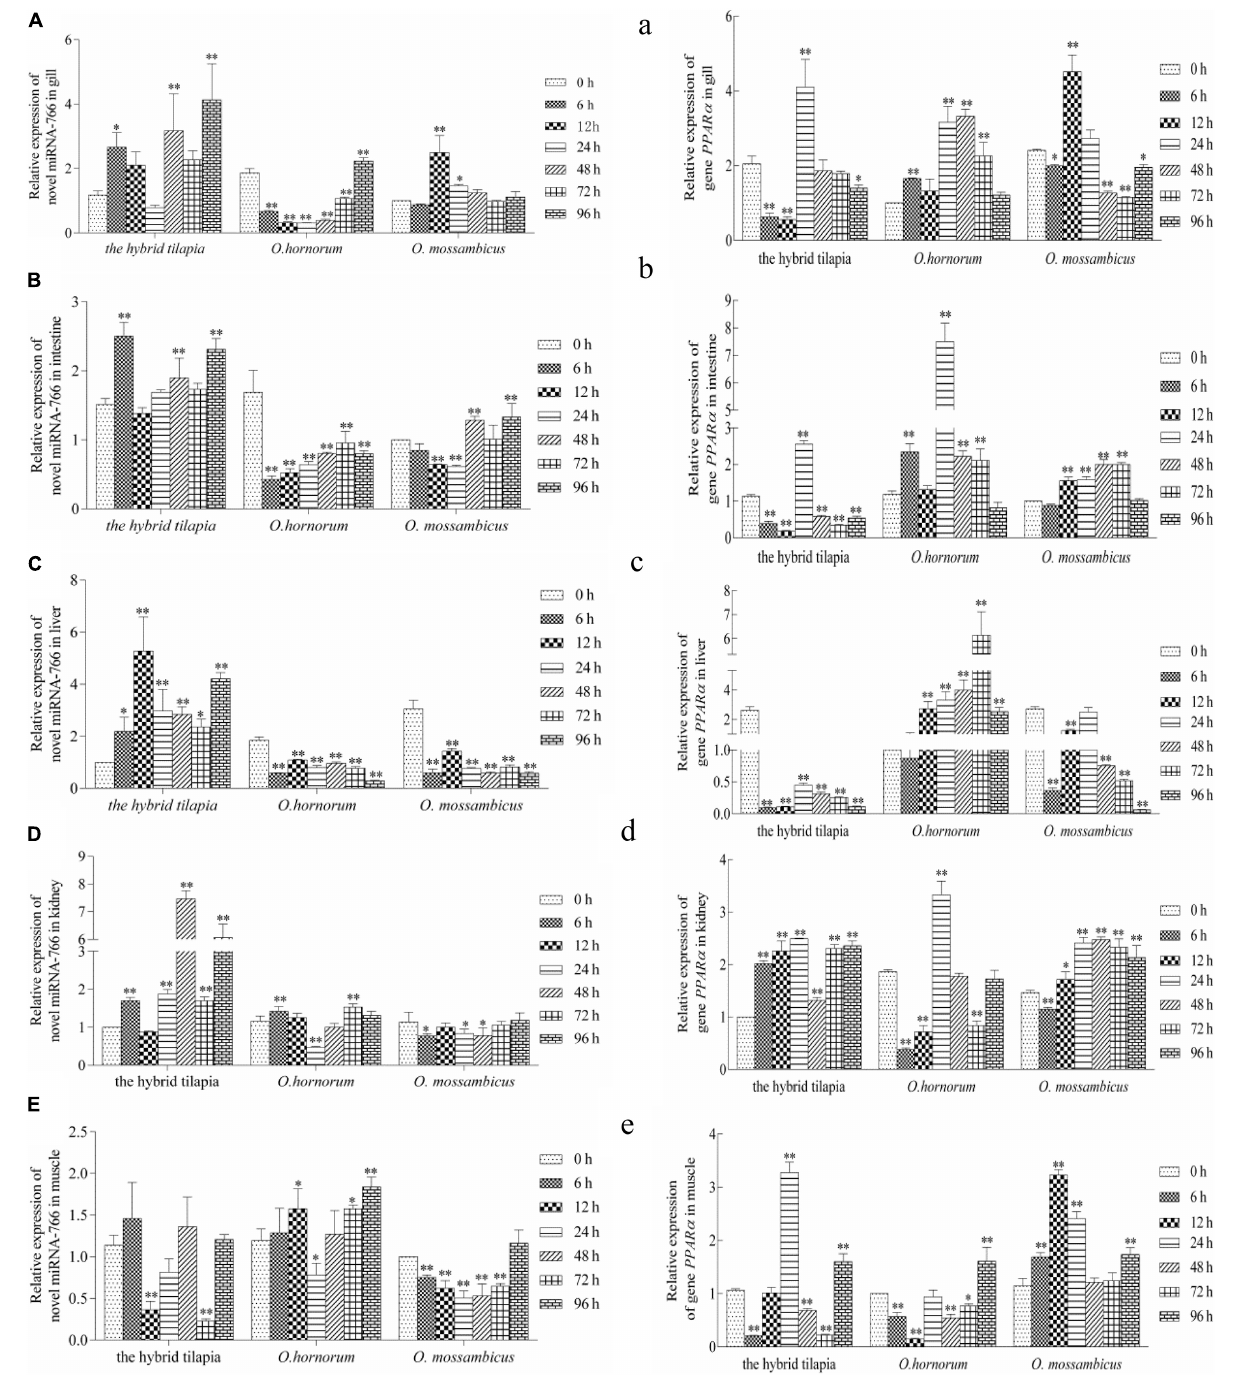
regulated functions of miRNA and its target genes under to investigate further the biological functions and network